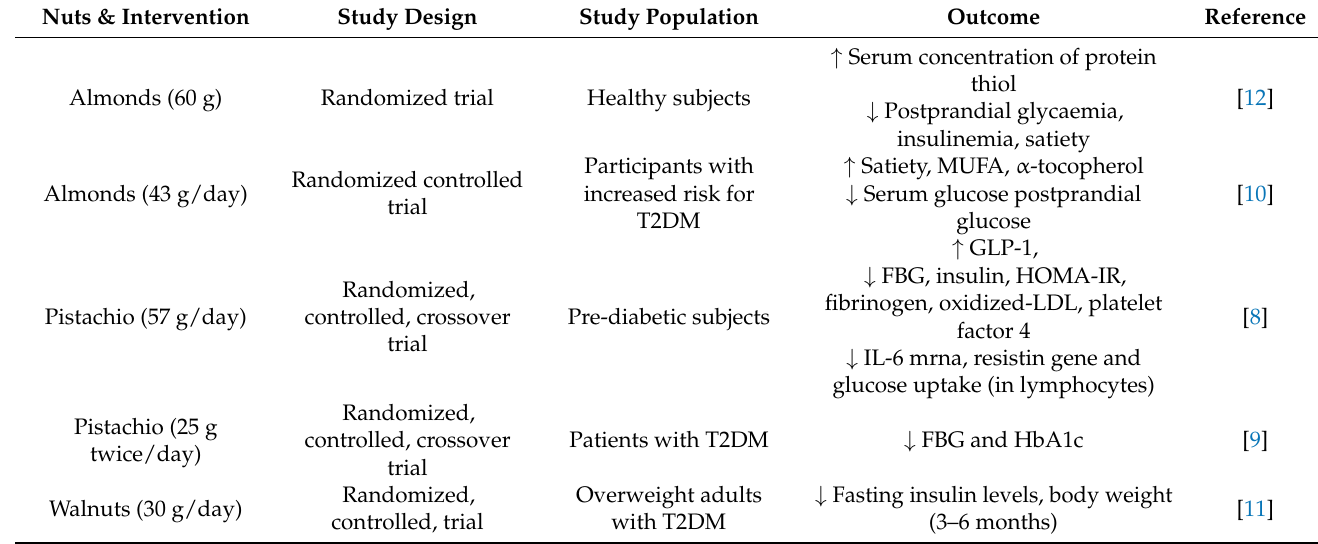
Table 1. Glucose modulation effects related to nut